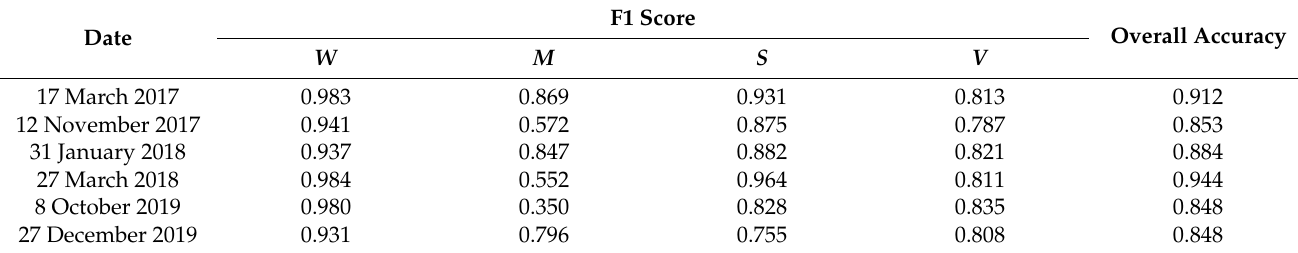
Table 9. Performance metrics estimated for “predicted” L8 indices compared with “ground truth” S2 indices.